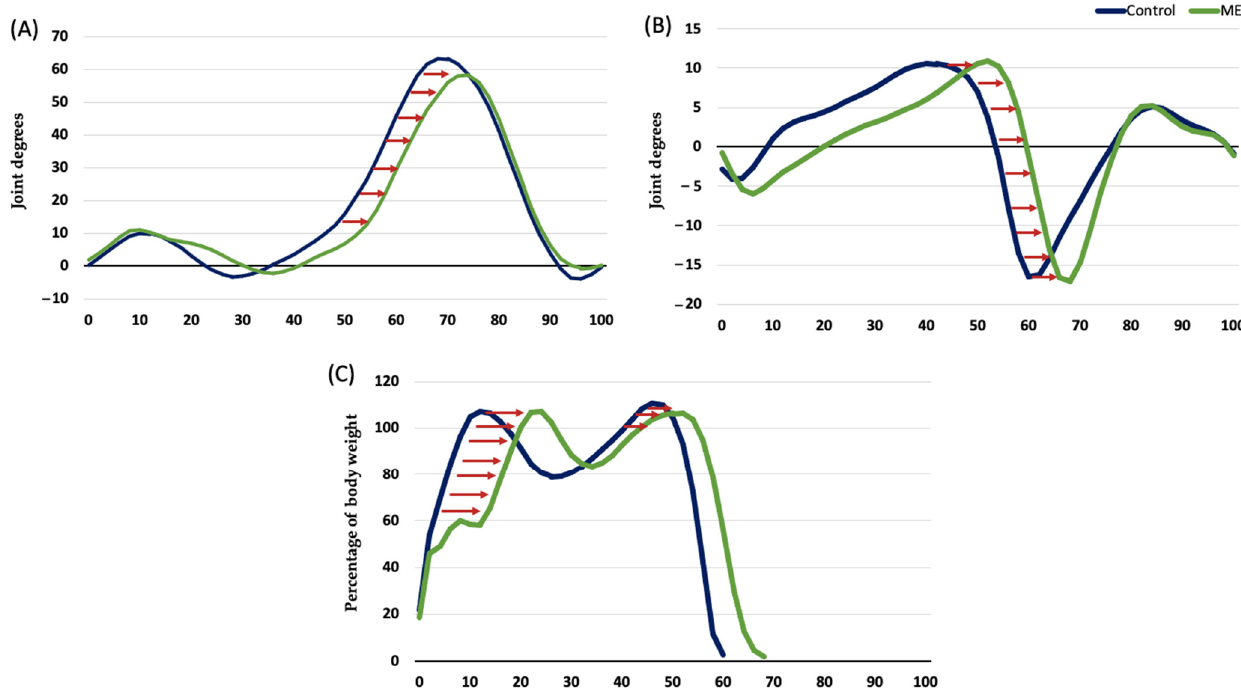
Figure 1. ( A ) Timing of the knee kinematics; ( B ) Timing of the ankle kinematics; ( C ) Timing of the vertical ground reaction forces. ( A – C ) x -axis is percentage of the gait cycle. ( A , B ) y -axis is joint degrees. ( C ) y -axis is percentage of body weight. The blue line is the control group; the green line is the MS group.